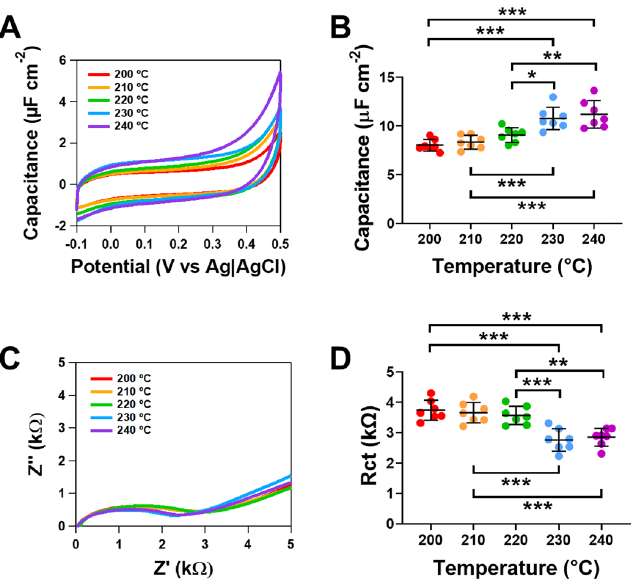
Figure 4. Comparing the capacitance and resistivity of 3D printed electrodes made using varying extruder temperatures where the nozzle diameter was 0.6 mm and heated bed temperature was 50 °C. ( A ) Cyclic voltammograms in 1 M KCl at 0.1 V s −1 ( B ) overall capacitance data for electrodes are varying printing speed. ( C ) Nyquist plots for the electrodes made at different print speeds. ( D ) Overall responses for the charge-transfer resistance ( R ct). Data shown as mean ± SD, where n = 7, * p < 0.05, ** p < 0.01 and *** p <